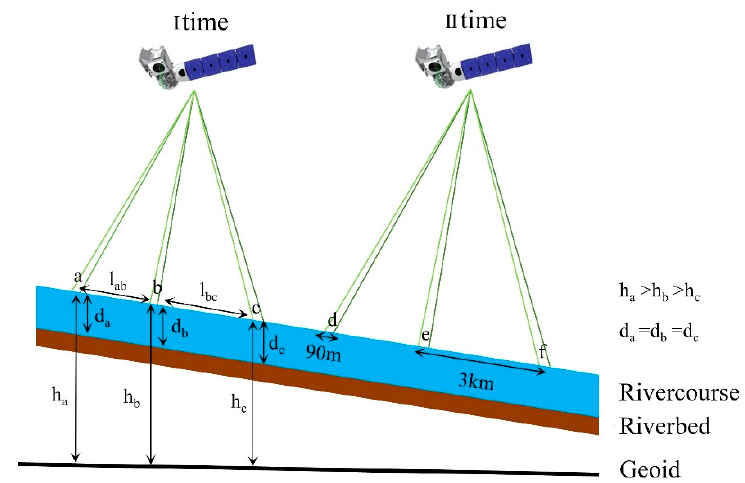
Figure 3. Schematic diagram of ICESat-2 measurement of water level in the Yarlung Zangbo River.